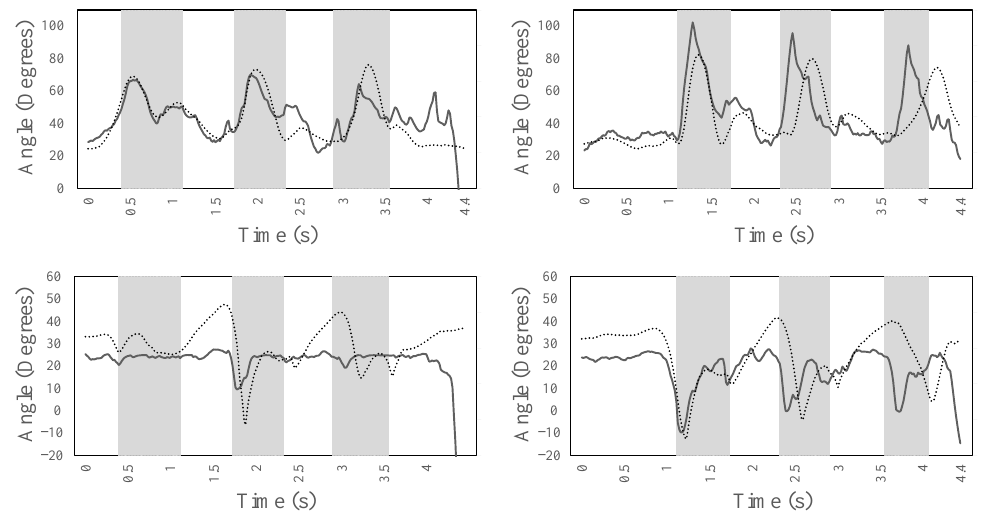
Figure 10. The angles of the left/right knee ( top ) and of the left/right ankle joint ( bottom ) during ramp ascent for the entire simulation time. The areas marked in gray show the period where the leg is not in contact with the ground. The dotted lines are the experimental data; the continuous lines are the forward dynamic simulation